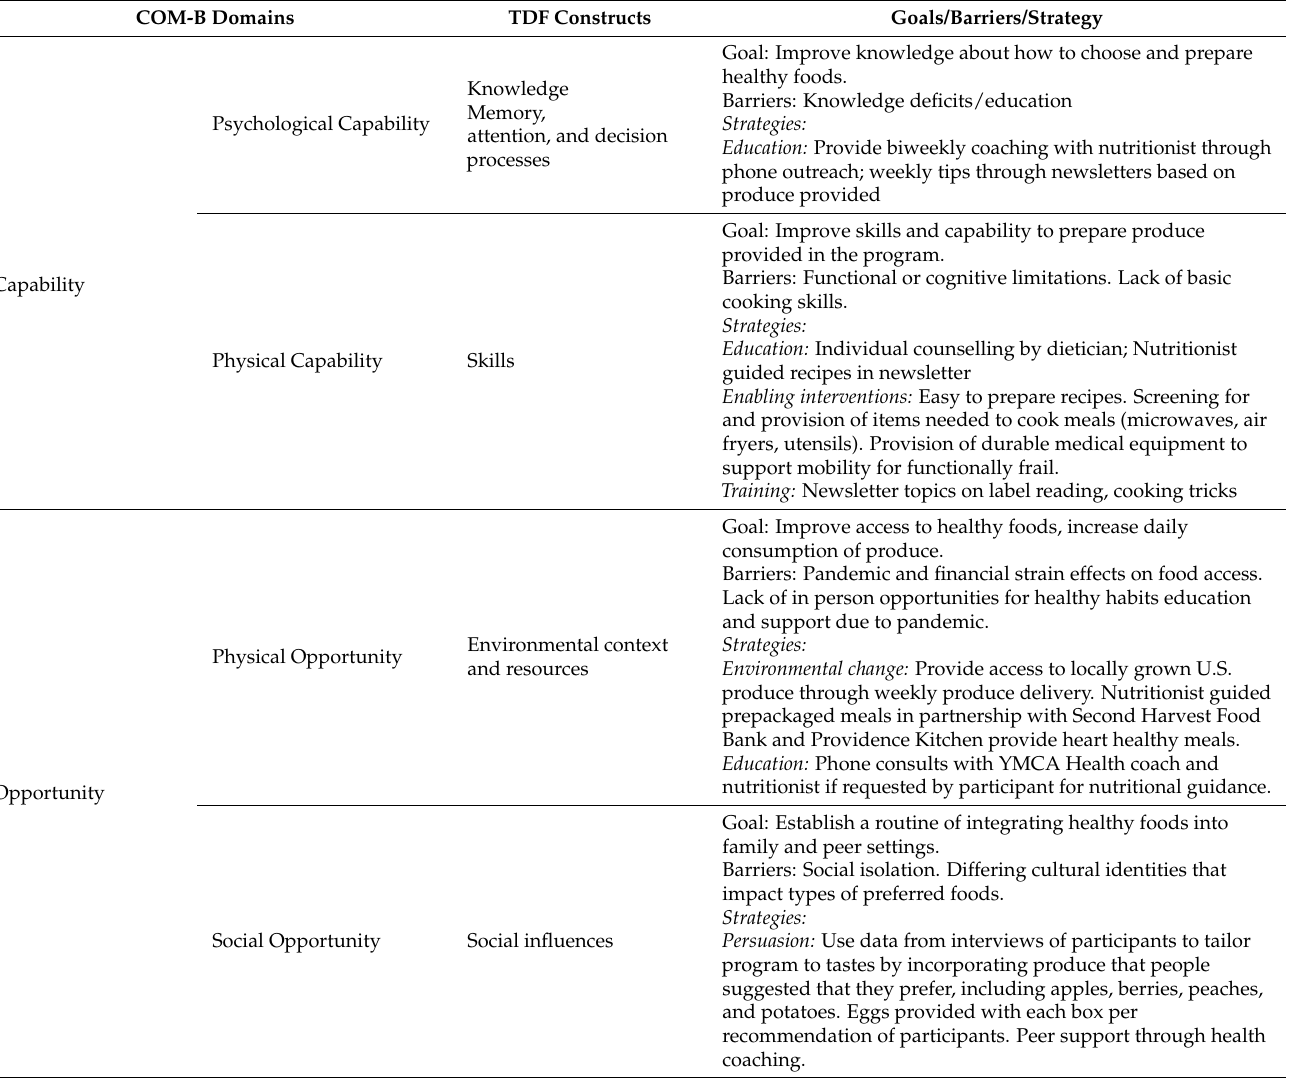
Table 1. Mapping of the COM-B to TDF Domains and Strategies to Evaluate the Impacts of Interven- tions on Dietary Behaviors